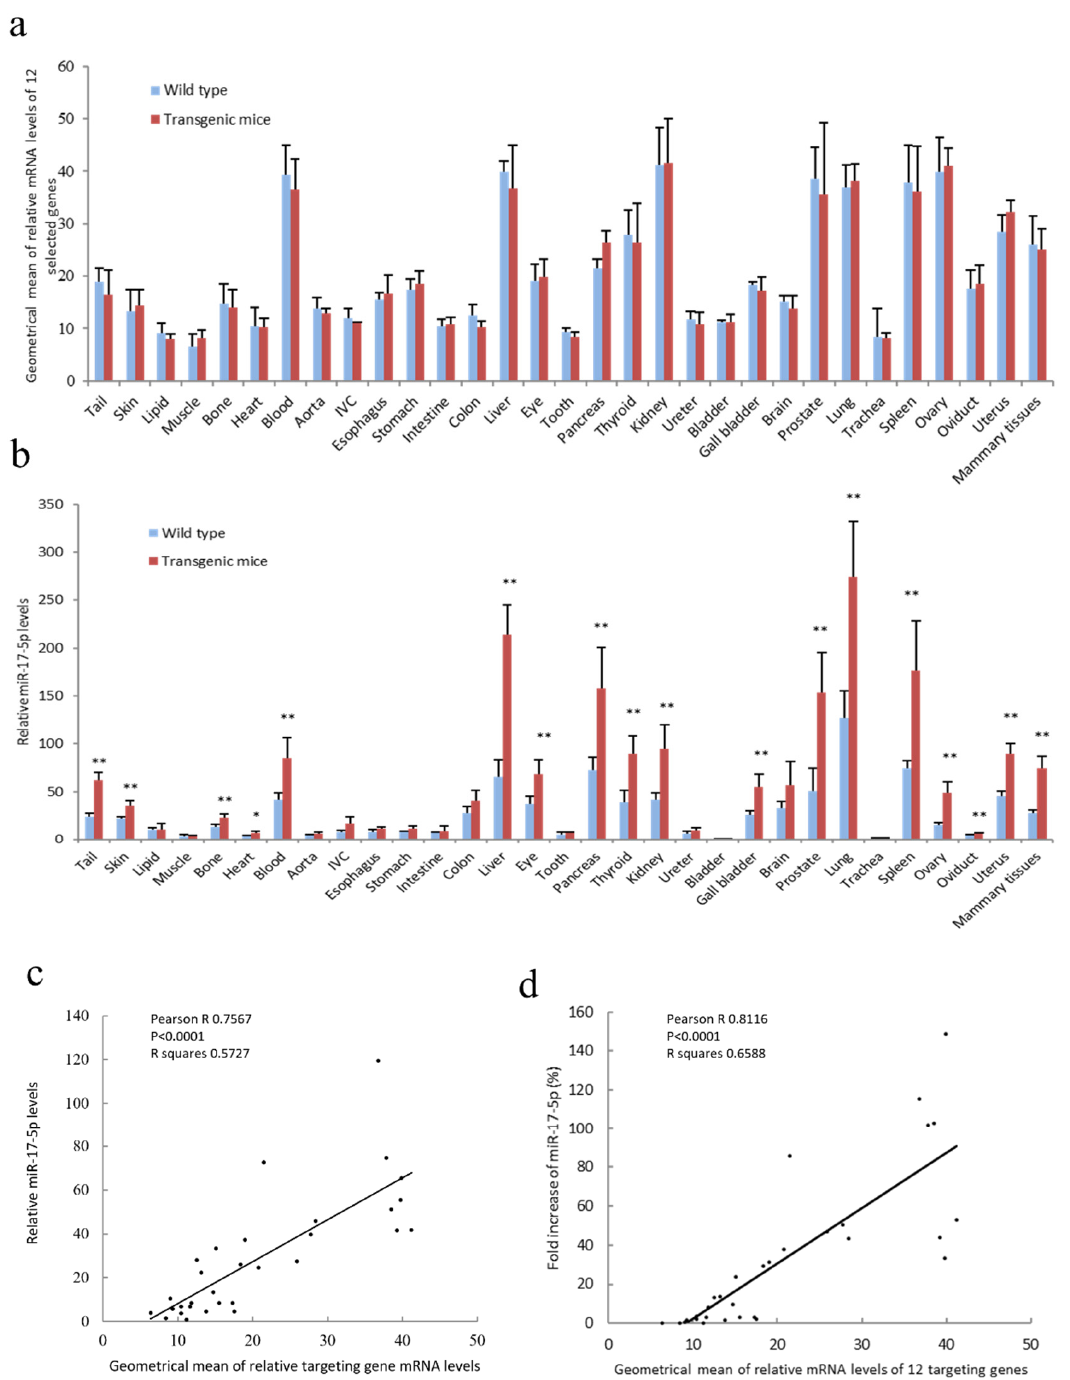
Figure 1. miR-17-5p expression was positively correlated with the selected target mRNAs in trans- genic mice. ( a ) Total RNAs were collated from tissues of 31 different mouse organs and subjected to reverse transcription and real-time PCR using primers against 12 selected miR-17-5p target genes, including p21, PTEN, bcl2l11, E2F1, Rb1, Rbl2, cyclin D1, NCOA3, PCAF, CTGF, STAT3, and ADCY5. Bars show the geometrical means of these miR-17-5p target mRNAs in wild-type and miR-17 trans- genic mouse tissues. Error bars, SD; n = 4. ( b ) Mouse organ tissues were subjected to PCR, showing that miR-17 transgenic mice expressed increased miR-17-5p levels compared to WT mice. The expression levels of miR-17-5p are different in different organ tissues. * p < 0.05, ** p < 0.01 vs.